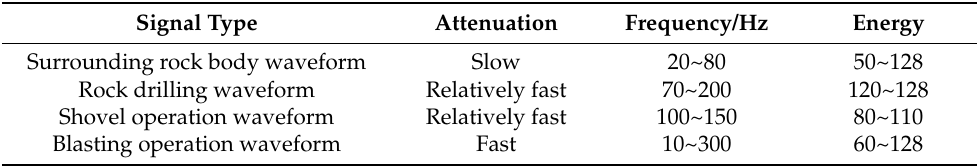
Table 2. Parameter characteristics of different types of acoustic emission waveforms.